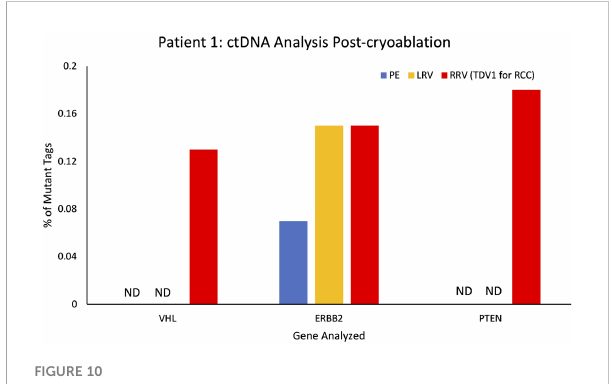
FIGURE 10 ctDNA analysis for Patient 1 from peripheral and tumor-proximal vein samples, post-cryoablation of a renal cell carcinoma (RCC). Higher variant allele frequencies (VAFs) were seen in the samples from the tumor-proximal right renal vein (RRV, TPV1 for the RCC, in red) compared to peripheral vein (PE, in blue), post-cryoablation, for VHL (87V>P), ERBB2 (424V>L) and PTEN (F215Lfs*6 NS). VAF for ERBB2 (424V>L) was comparable in the RRV and the left renal vein (LRV, in yellow). ND – not detected, VAF – variant allele